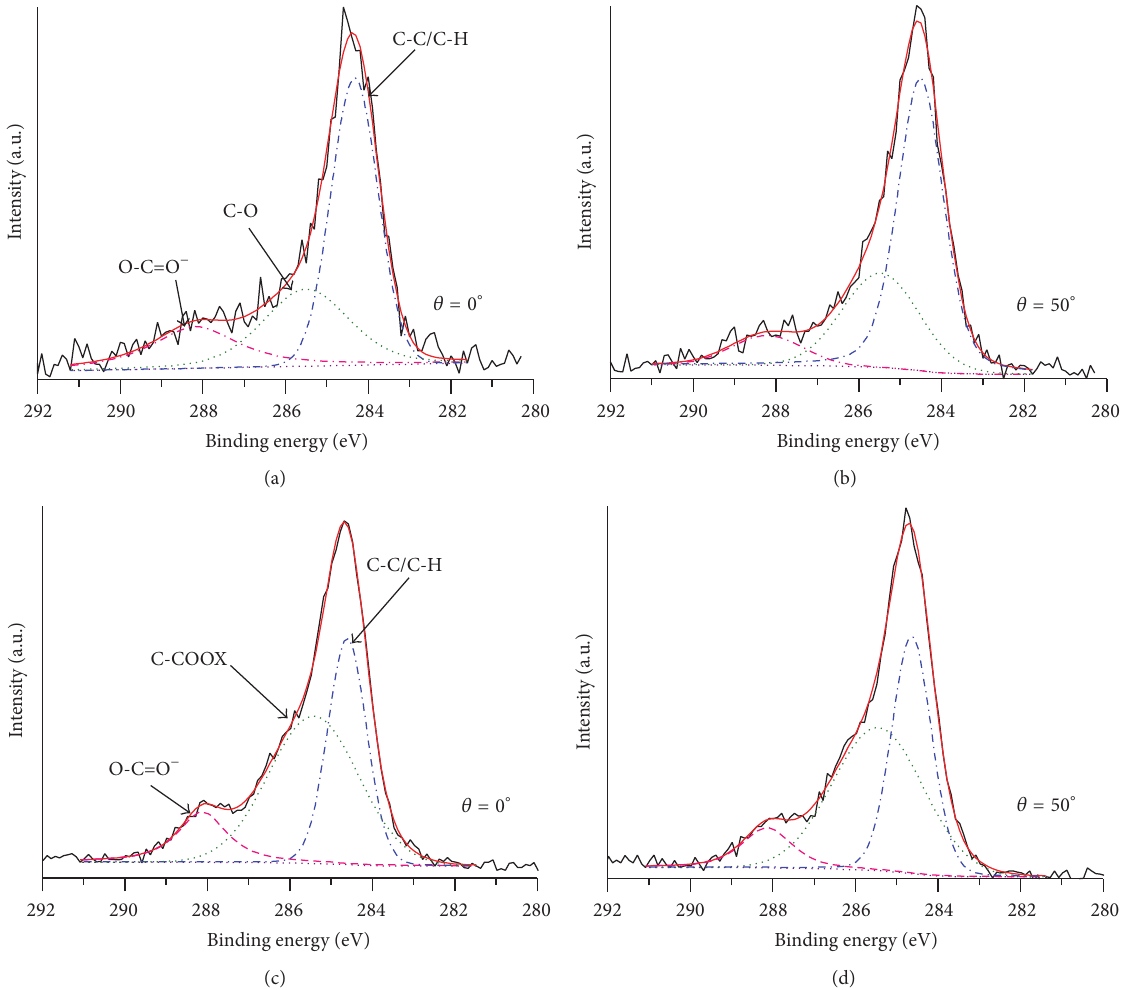
Figure 8: High resolution C 1s spectra for native oxide film on carbon steel (a, b) and for carbon steel sample after 2 h immersion in 0.02 M NaCl solution containing 0.1M sodium glutarate (c, d). In each case, results for two different takeoff angles (0 ∘ and 50 ∘ ) are